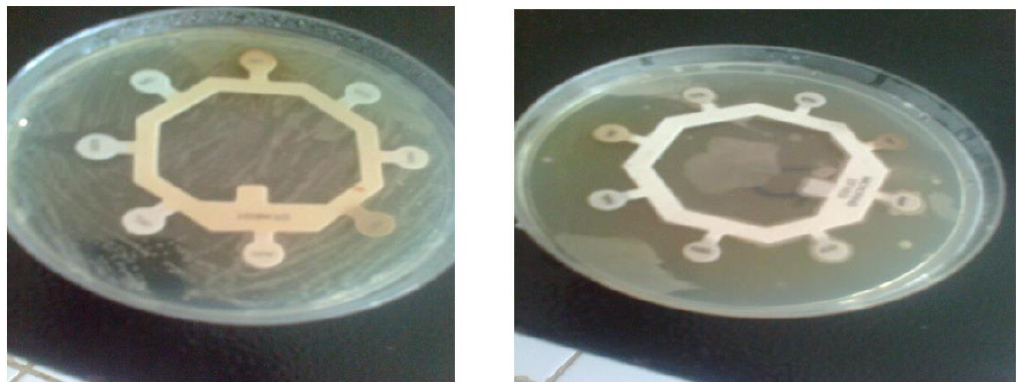
Plate 6. Photograph of E. coli susceptibility test before and after plasmid